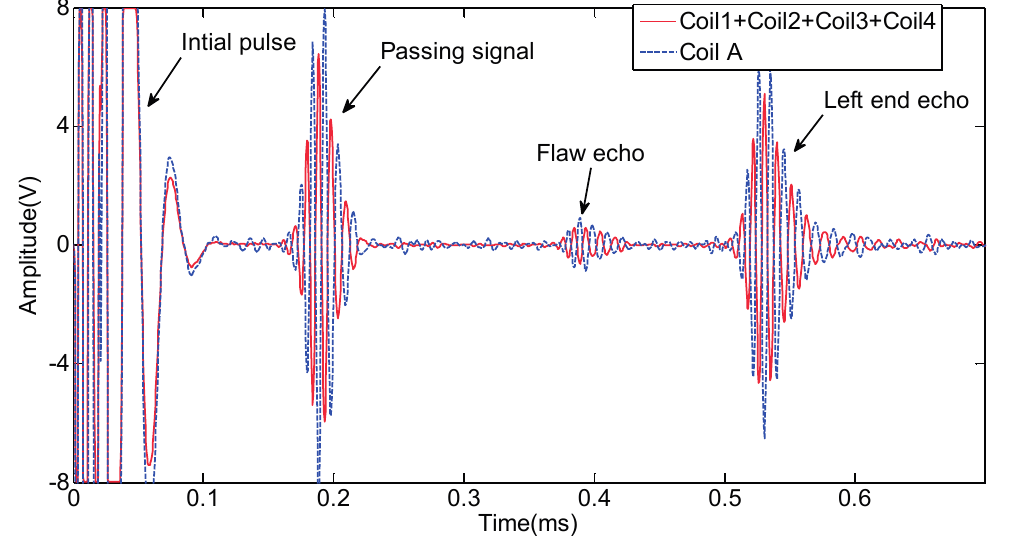
Figure 9. Added signal induced by the four coils (induced Zone III) and the signal induced by Coil A (induced Zone II + Zone